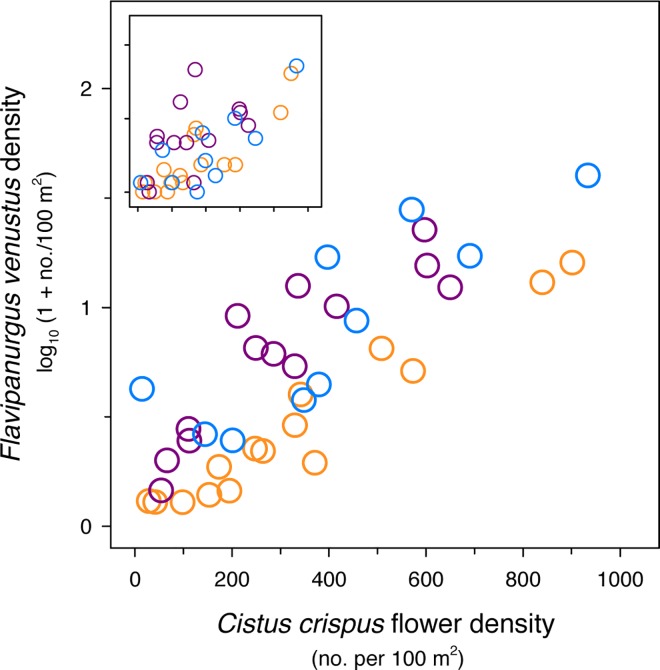
Relationship between the density of Flavipanurgus venustus and that of Cistus crispus flowers in the study woodland patches.n
total = 38 ‘woodland patch × year’ combinations; orange, purple and blue circles are 2011 (n = 15 patches), 2012 (n = 13) and 2013 (n = 10) data, respectively. The large panel shows bee densities predicted by the model that included the sampling date (Julian day) as covariate. The inset represents the observed bee densities (same scale as the large panel in both axes).